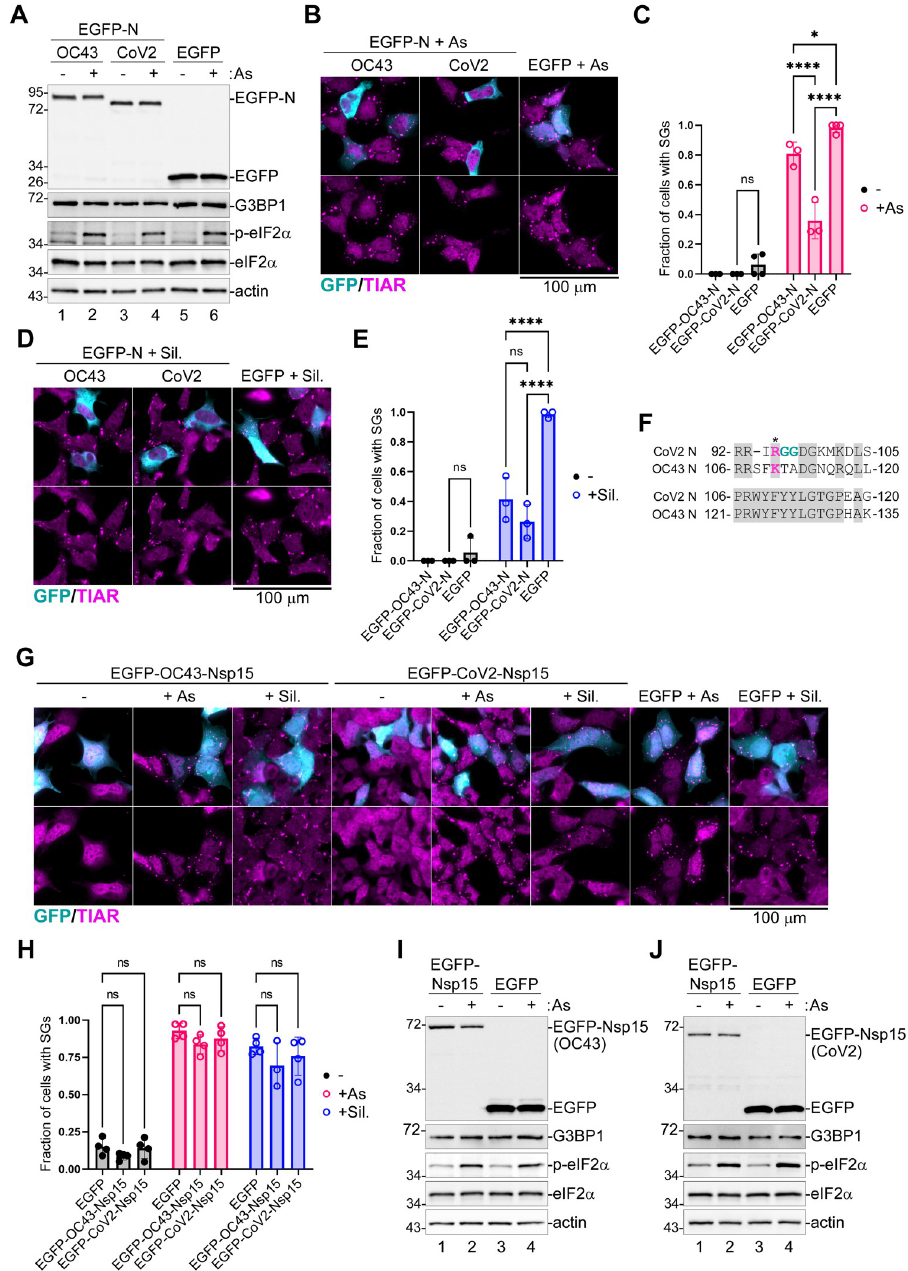
Fig 4. Coronavirus N proteins inhibit SG formation downstream of eIF2 α phosphorylation. 293A cells were transiently transfected with the indicated EGFP-tagged viral protein expression constructs or EGFP control. At 24 h post-transfection cells were treated with sodium arsenite (+ As) or Silvestrol (+ Sil.), as indicated, or left untreated. SG formation was analyzed by immunofluorescence microscopy with staining for SG marker TIAR (magenta). EGFP expression is shown in teal. Scale bars = 100 μ m. Levels of EGFP-tagged proteins and the As-induced phosphorylation of eIF2 α were analyzed by western blot. (A) Western blot analysis of cells transfected with EGFP-tagged OC43 or CoV2 nucleoprotein (EGFP-N) expression vectors or control EGFP-transfected cells. (B) Immunofluorescence microscopy of EGFP-N transfected, or control EGFP-transfected cells treated with arsenite. (C) Fraction of transfected cells with As-induced SGs quantified from B. (D) Immunofluorescence microscopy of EGFP-N transfected or control EGFP-transfected cells treated with Silvestrol. (E) Fraction of transfected cells with Silvestrol-induced SGs quantified from D. (F) Alignment of CoV2 and OC43 N amino acid sequences in the vicinity of CoV2 RGG motif containing arginine 95 (red, indicated with asterisk). Identical and homologous amino acids are highlighted in grey. Numbers